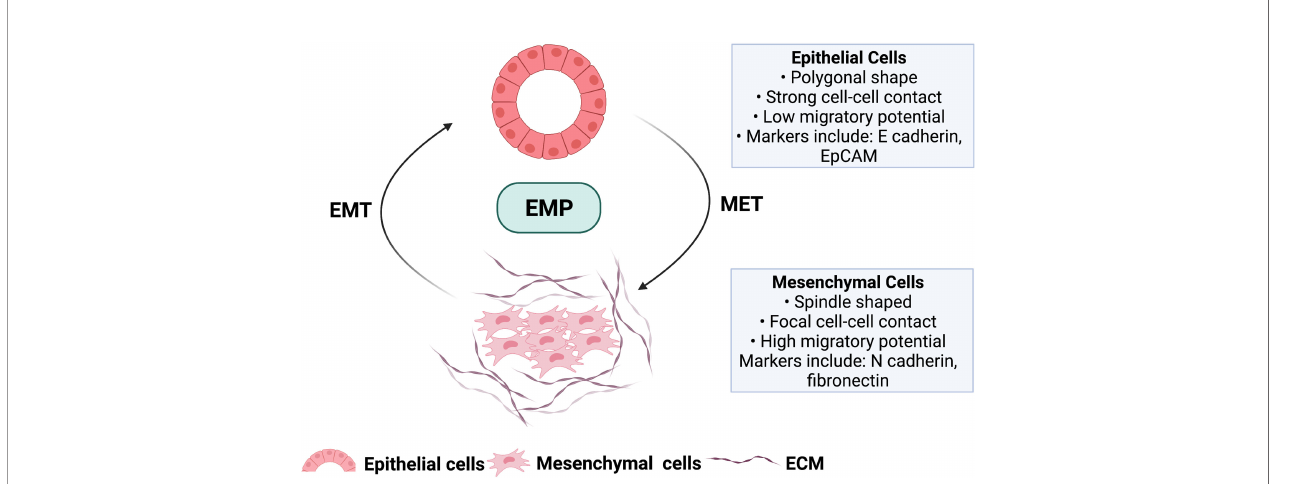
FIGURE 1 | Hallmark features of malignant epithelial cells undergoing forward differentiation towards mesenchymal cell type (EMT) and the reversal mesenchymal to epithelial transition (MET). These two biological processes give rise to the concept of epithelial to mesenchymal plasticity (EMP) involved in tumor progression and metastasis. ECM; Extracellular matrix. Image created with BioRender.com (Agreement number